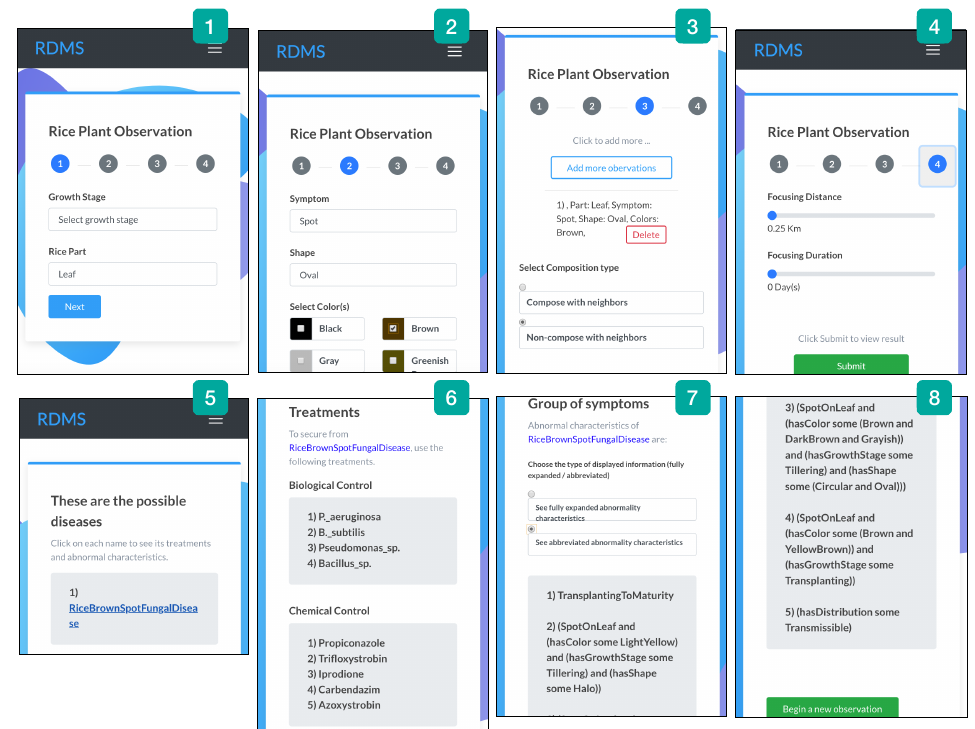
Figure 6. Sequential steps of using the RiceMan’s user interfaces from providing observation data (a user’s input) to receiving the results.